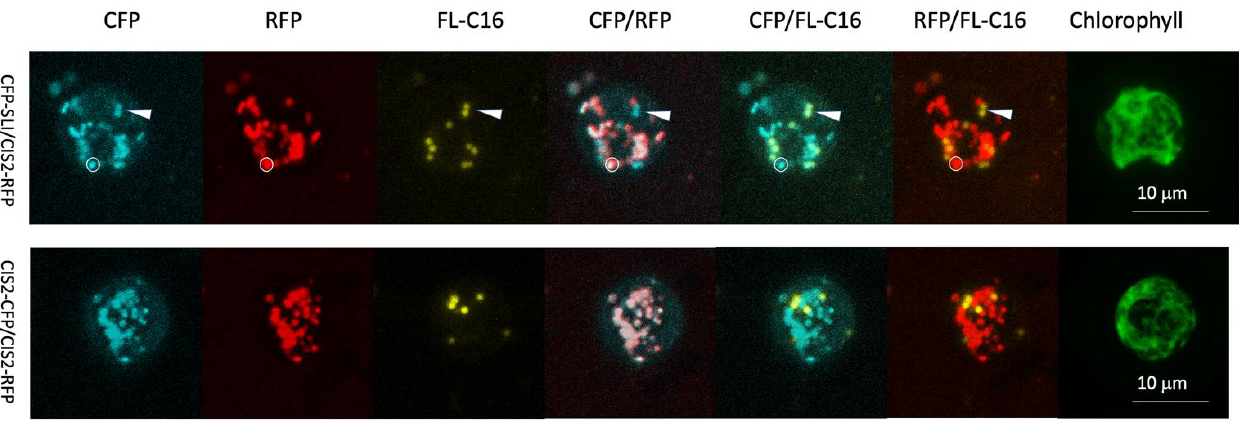
Figure 2. Co-localization of FL-C16 and CFP-SLI (PTS1 containing peroxisomal targeting protein) was identified in C. reinhardtii . Accumulations of FL-C16 and peroxisomal marker proteins after the cells were cultured in TAP for 24 h in illuminated conditions. Thirty optical sections of each 20 µm z-stack are projected into a plane image with maximum intensity. CFP-SLI: CFP fused to the PTS1 signal peptide serin-leucine-isoleucine. CIS2-RFP: Twenty-five N-terminal amino acid sequences of glyoxylate cycle enzyme citrate synthase 2 (CIS2) fused to RFP. CIS2-CFP: CIS2 fused to CFP. A compartment that contains CIS2-RFP and CFP-SLI but not FL-C16 is shown with a white circle. A pair of compartments that contain FL-C16 and CFP-SLI but not CIS2-RFP are shown with an arrowhead (upper panel). Notice that CIS2-CFP and CIS2-RFP are all colocalized (lower panel), suggesting that non-colocalization between CFP-SLI and CIS2-RFP (marked with the arrowhead) is not an artifact by protein expression or imaging acquisition.